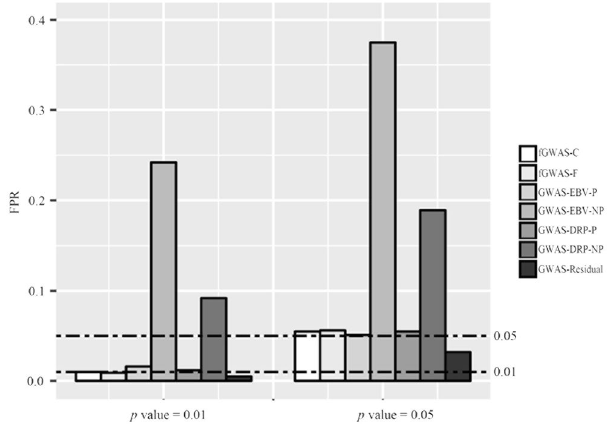
Figure 1. The type I errors (false positive rates, FPRs) of different GWAS models for the simulated data at the tabulated thresholds of p = 0.05 and p = 0.01 for the simulation